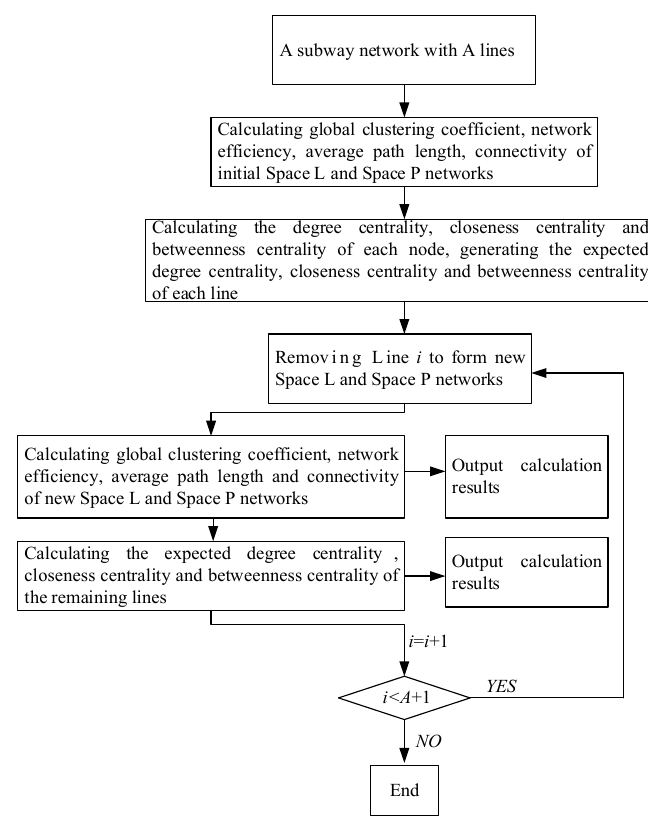
Figure 6. Key lines’ identification algorithm.